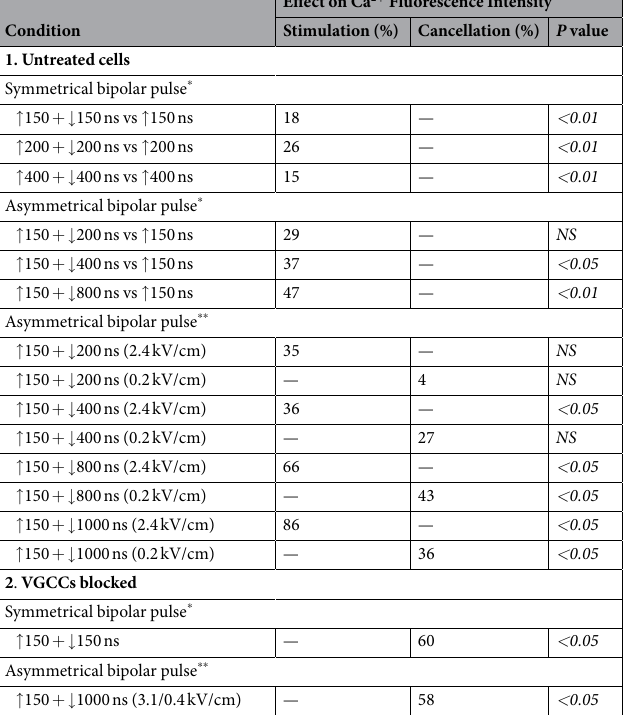
Table 1. Summary of bipolar nsPEF parameters that evoked maximal stimulation or cancellation of Ca 2 + influx elicited by a 150 ns unipolar pulse. * 3.1 kV/cm each phase. ** 3.1 kV/cm positive phase, varied amplitude and duration of the negative phase. NS: Not